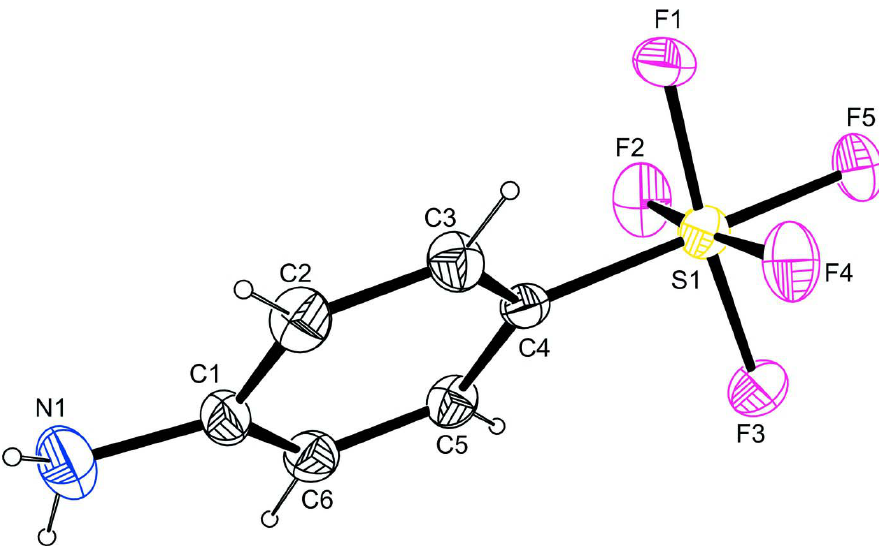
Figure 1 Molecular view of I with the atom-labelling scheme. Displacement ellipsoids are drawn at the 30% probability level. H atoms are represented as small sphers of arbitrary